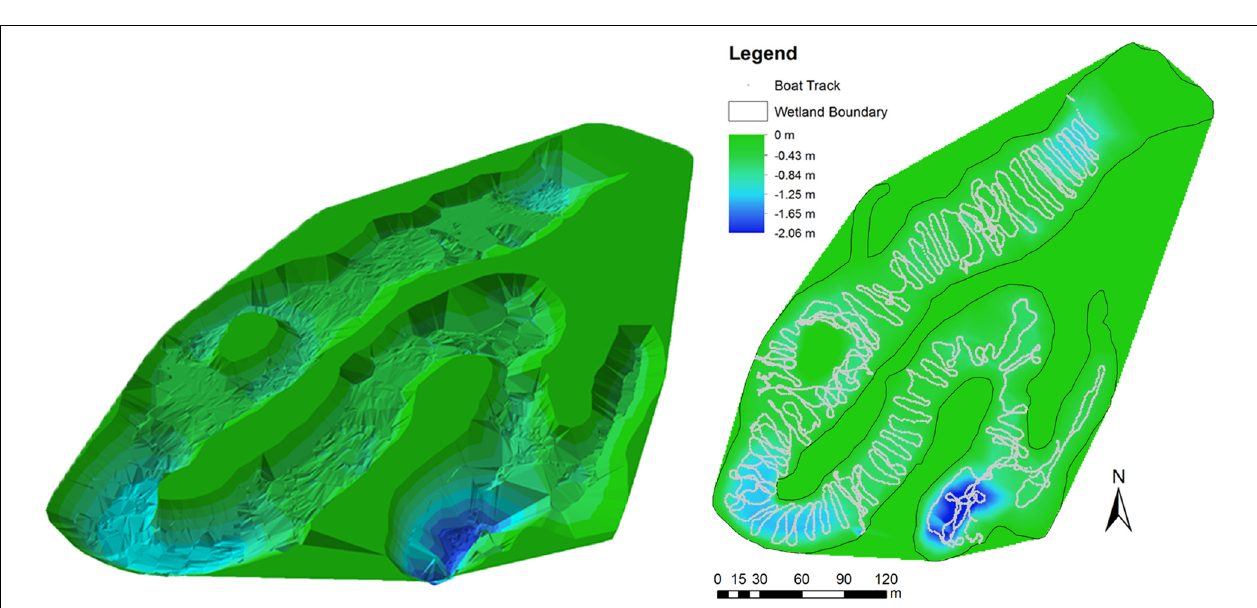
FIGURE 6 | Sludge bathymetry in a pond that was reported to be displaying abnormal hydraulic behavior. Color scale indicates sludge height from the bottom of the pond in meters. The most significant feature in this profile is the U-shaped channel that has formed around the eastern edge of the pond. The inlet is located at approximately